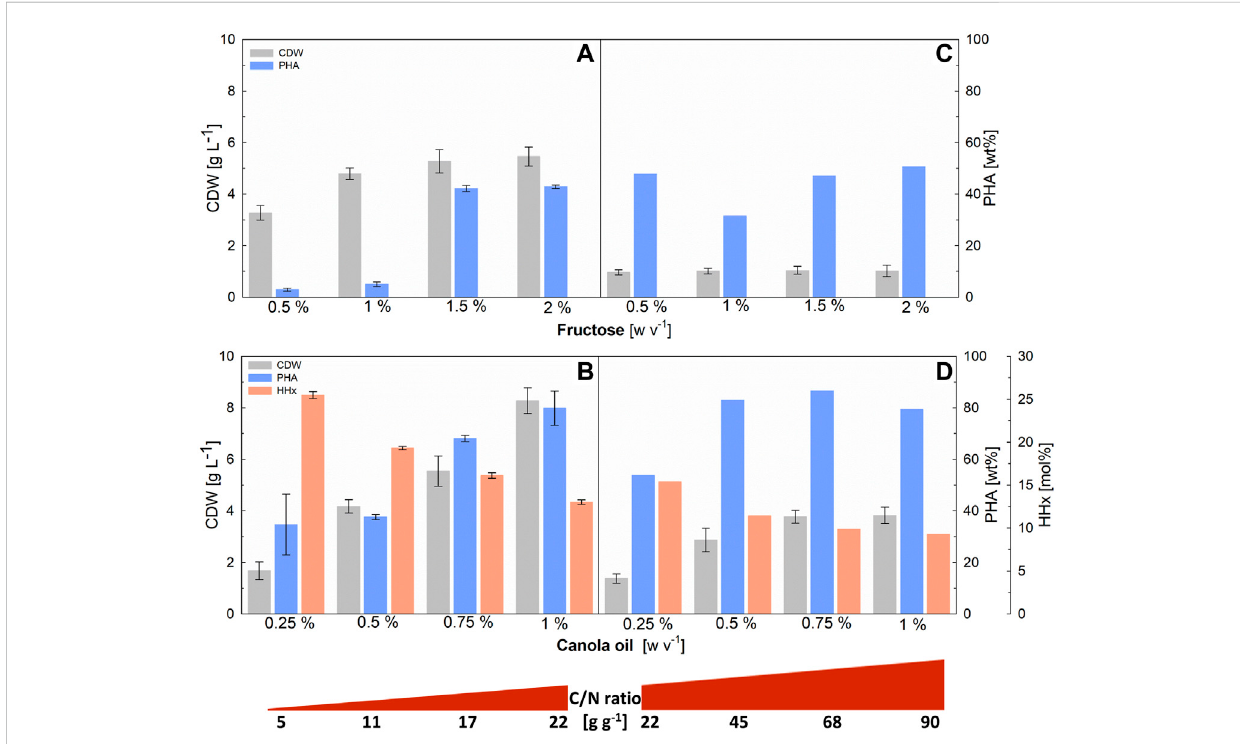
FIGURE 1 Evaluation of C/N ratios in 3-mL deep-well-plates for R. eutropha Re2058/pCB113 cultivations using fructose or canola oil as carbon source and urea as nitrogen source. Cell dry weight (CDW; g L − 1 ), PHA content of CDW (PHA; wt%) and HHx content of PHA (HHx; mol%) achieved after 72 h of cultivation with different C/N ratios (g g − 1 ) are shown. Left graphs show the results of low C/N ratios achieved with 0.744 g L − 1 urea and different (w v − 1 ) concentrations of fructose (A) and total-carbon-equivalent canola oil concentrations (B) . Right graphs show the results of high C/N ratios obtained with the same fructose (C) and canola oil (D) concentrations and 0.186 g L − 1 urea. CDW error bars indicate standard deviation from biological triplicates. PHA and HHx error bars represent standard deviation from duplicate measurements of pulled samples [in (C,D) the scarce amount of sample was only suf fi cient for a single